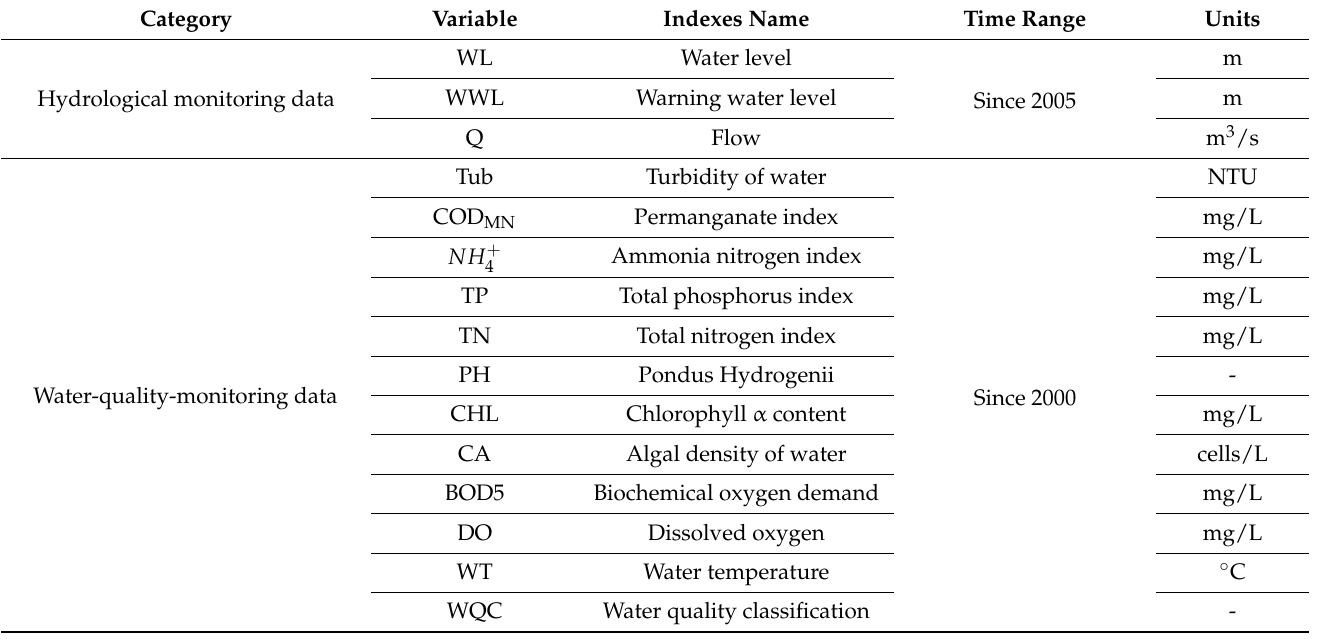
Table 2. Features of the obtained data in the